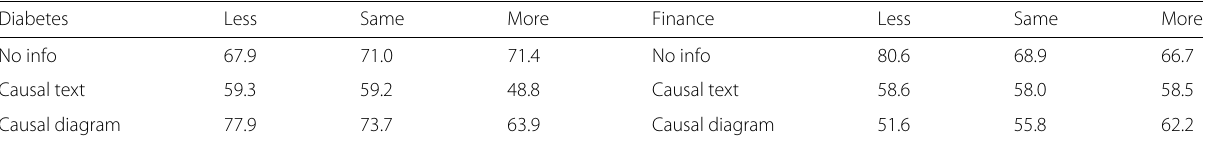
Table 5 Percentage of participants correctly answering the decision-making question for Experiment 4 by level of self-perceived expertise Diabetes Less Same More Finance Less Same More No info 67.9 71.0 71.4 No info 80.6 68.9 66.7 Causal text 59.3 59.2 48.8 Causal text 58.6 58.0 58.5 Causal diagram 77.9 73.7 63.9 Causal diagram 51.6